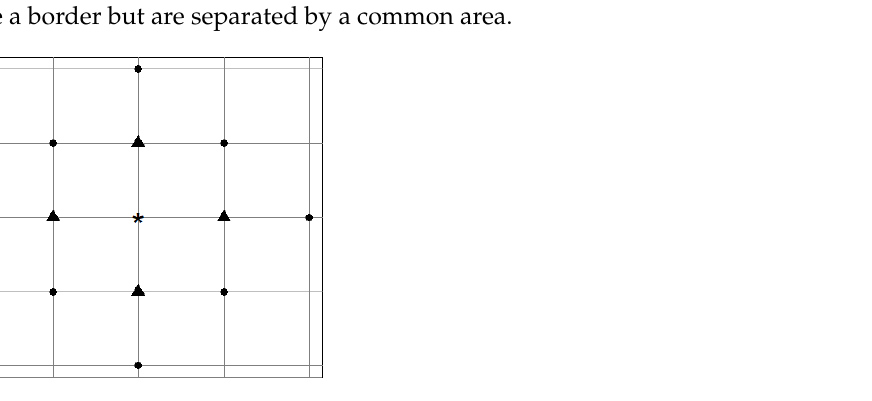
Figure 3. First- (triangles) and second- (circles) order spatial neighbours of a site (labelled by a star) in a regular